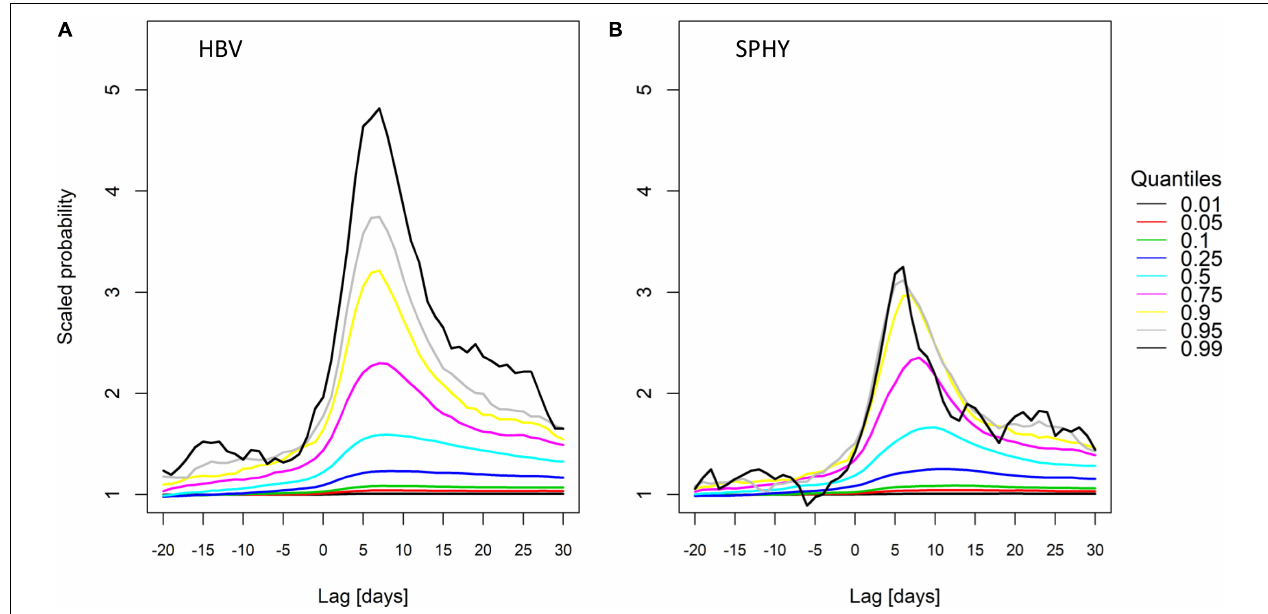
FIGURE 10 | Probability for getting river discharge above a certain quantile (A) HBV and (B) SPHY, given that total water levels also exceed the 97.5 th quantile. For each discharge quantile, the probability is scaled by the random probability of the event.